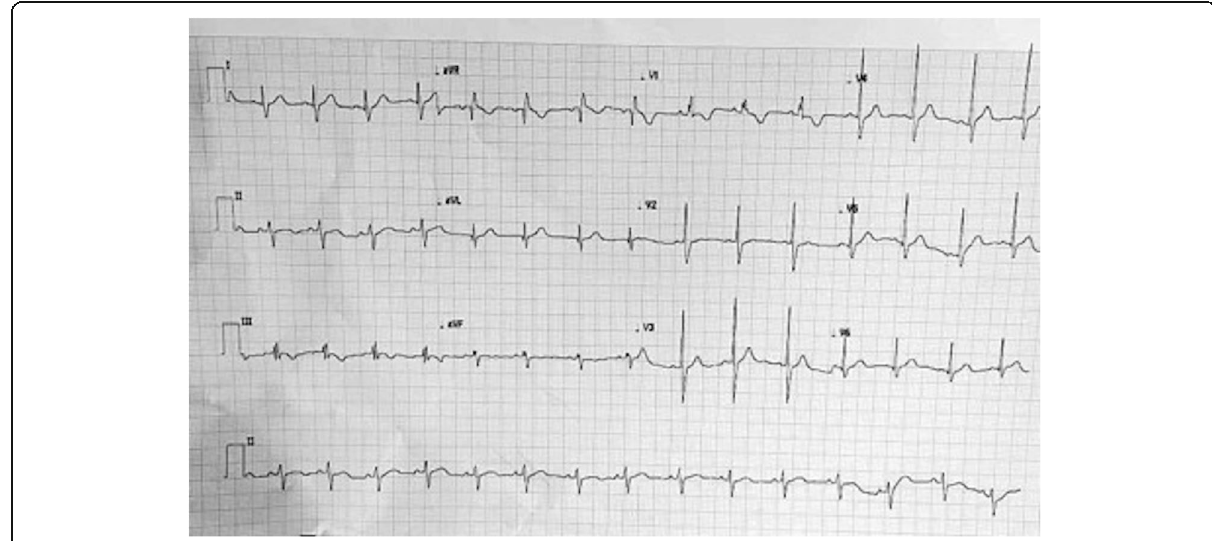
Fig. 1 Twelve-lead electrocardiogram showing incomplete right bundle branch block and notching in inferior leads suggestive of crochetage sign seen in secundum atrial septal